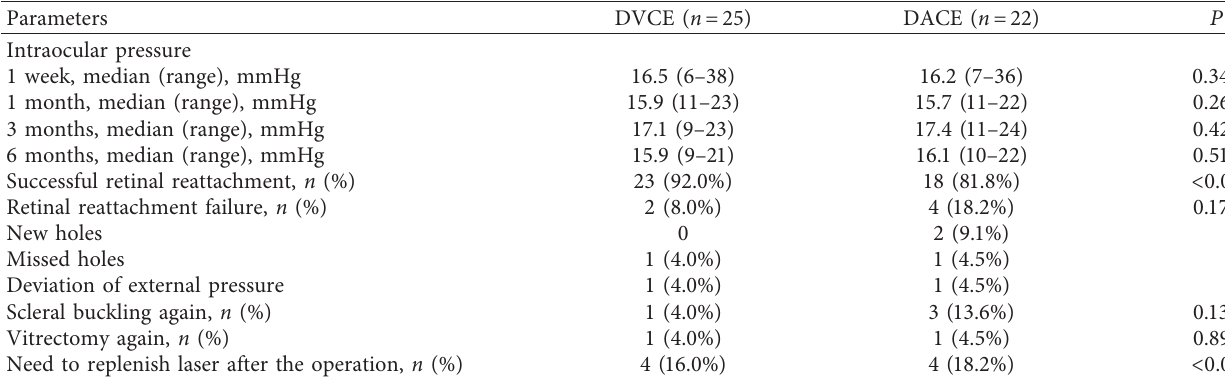
Table 4: Postoperative